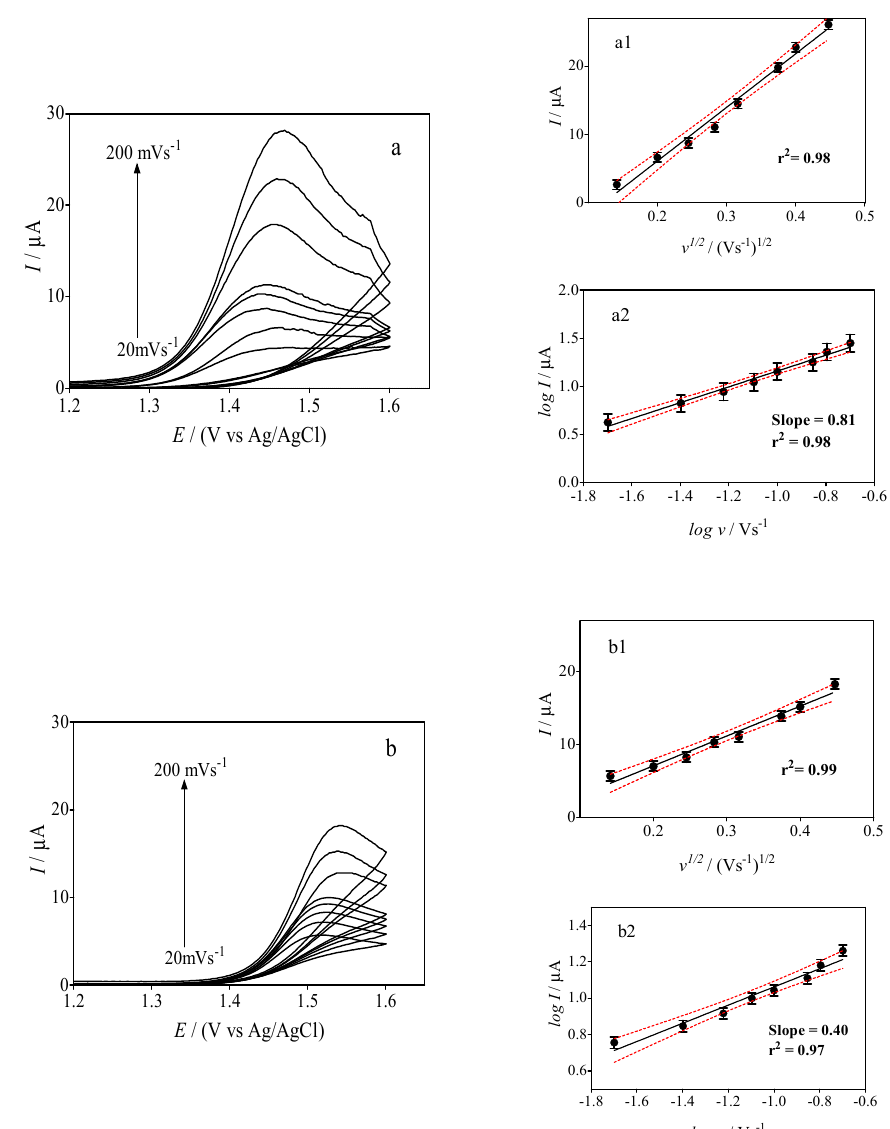
Figure 4. Cyclic voltammograms registered at different scan rates (20–200 mV s − 1 ) using ( a ) GrRAC and ( b ) GrRGC sensors, in the presence of 0.01 M caffeine in 0.5 M H 2 SO 4 solution.